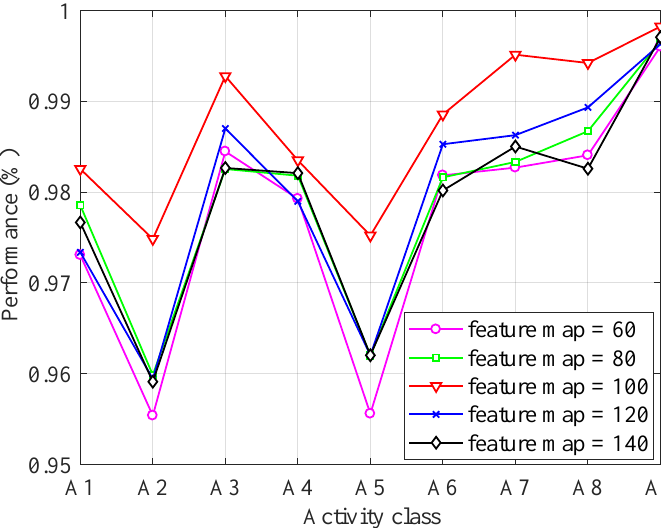
Figure 4. The performance with different feature map